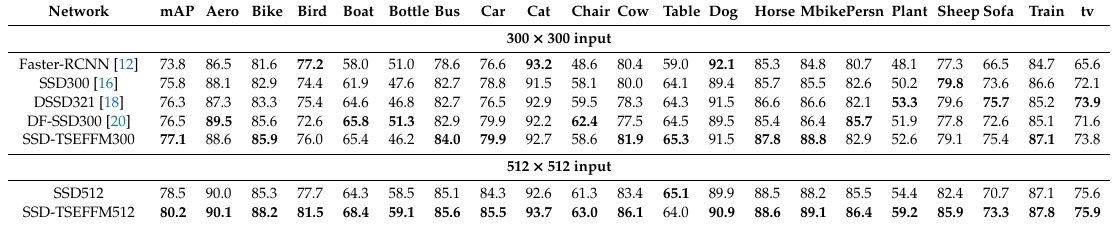
Figure 6. Comparison of object detection results of SSD-TSEFFM and SSD models tested on Pascal VOC dataset. Left panel images ( a , c , e , g , i , k , m , o ) are results obtained by SSD; right panel images ( b , d , f , h , j , l , n , p ) are results obtained by SSD-TSEFFM. Table 2. Average precision results tested on PASCAL VOC 2012 dataset (Bold values indicate the